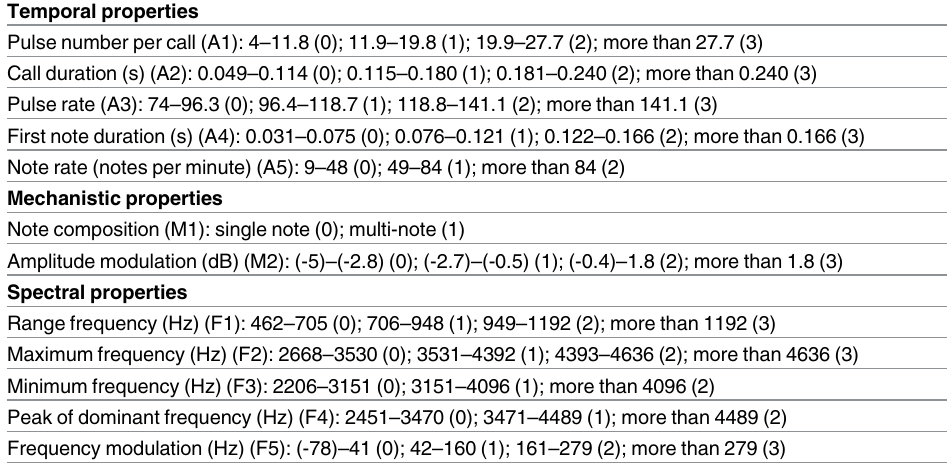
Table 1. Acoustic properties analyzed, character codes, and state delimitation for phylogenetic analysis. Temporal